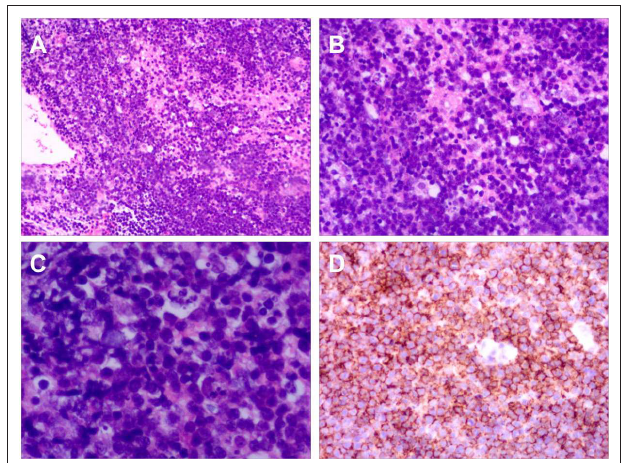
FIGURE 2 | Histopathology of Case 1. (A) Haematoxylin and eosin (H&E) × 10. (B) H&E × 25. (C) H&E × 100. H&E staining for brain tissue biopsy showed diffuse proliferation of large atypical lymphoid cells. (D) Immunohistochemical staining for CD20 showed that most cells were positive.